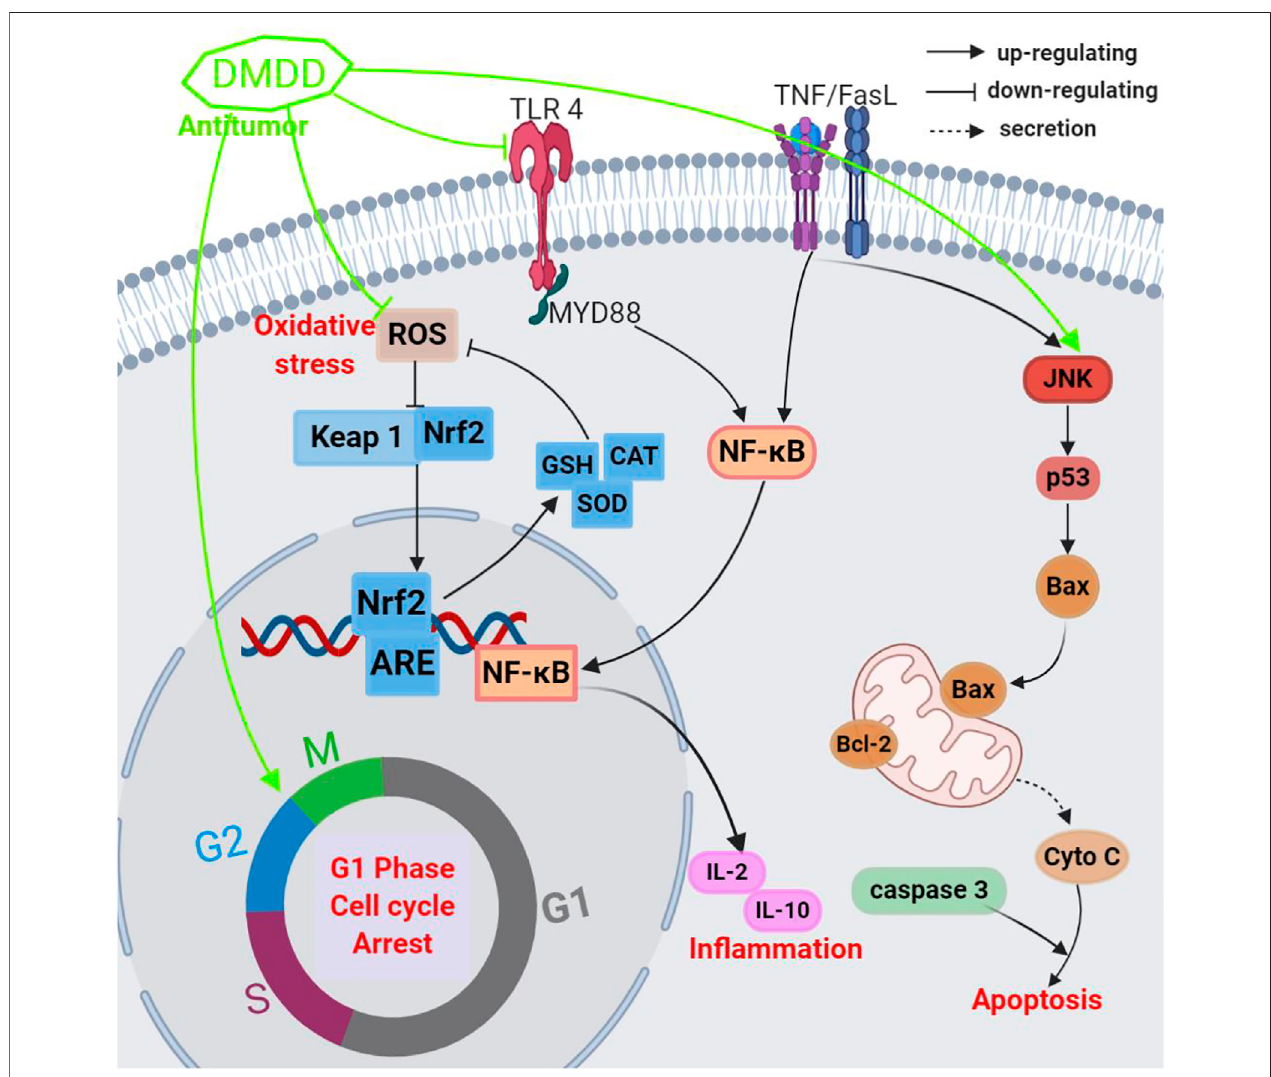
FIGURE 5 | Schematic representation of the underlying mechanism of anti-tumor activity of crude extracts or isolated compounds from A. carambola .